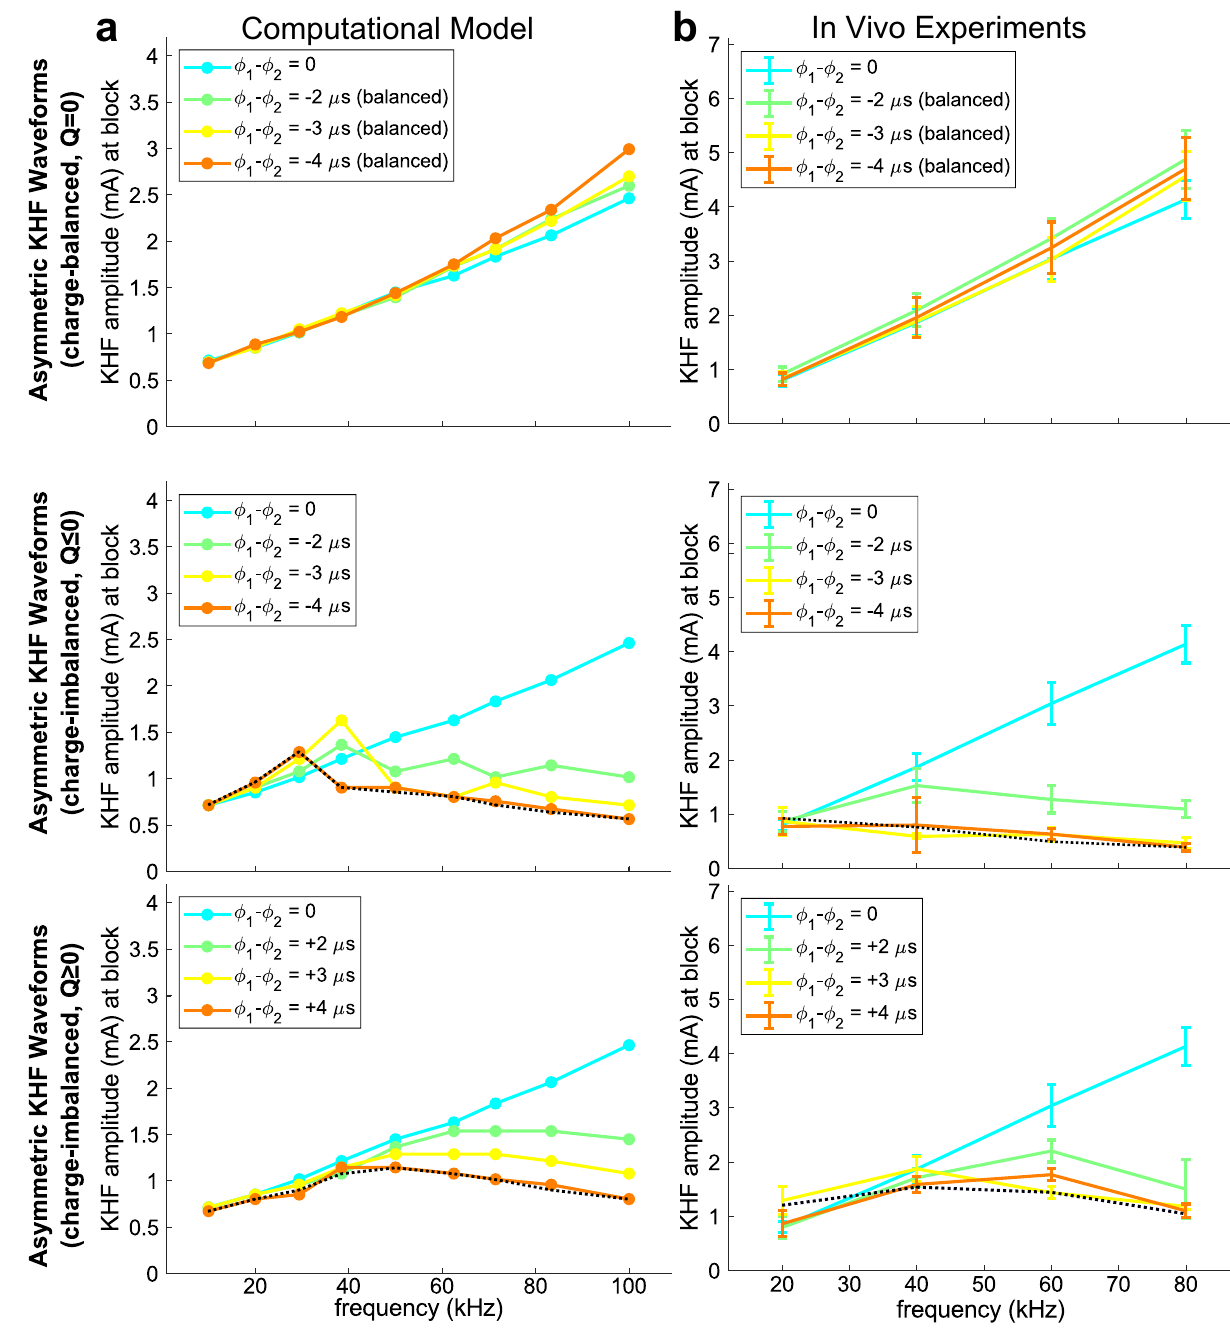
Figure 5. Frequency effects of asymmetric waveforms in computational models ( a ) and in vivo experiments ( b ). Waveforms were either charge-balanced with asymmetric phases plus compensatory DC offsets to cancel out imbalances (top row; Fig. 1e) or charge-imbalanced with asymmetric phases (middle and bottom rows; Fig. 1d). KHF amplitude was half of the peak-to-peak amplitude of the KHF waveform for all waveforms. The amount of asymmetry is shown as the difference in duration between the first (φ 1 ) and second (φ 2 ) phases of the biphasic KHF waveforms. The black dotted line in each charge-imbalanced waveform plot shows the corresponding ± 4 μA per mA KHF per 1 kHz line from Fig. 3 (computational model) or Fig. 4 (in vivo), which produced the same net charge per unit time as asymmetric charge-imbalanced waveforms with ± 4 μs phase difference. In charge-balanced asymmetric waveforms, only negative phase differences are shown, as the sign of asymmetry had no effect on threshold-frequency relationships. The 0 μs phase difference (cyan) lines for in vivo data are from the same data as in Fig. 4. See Supplemental Fig. 2 for individual nerve data